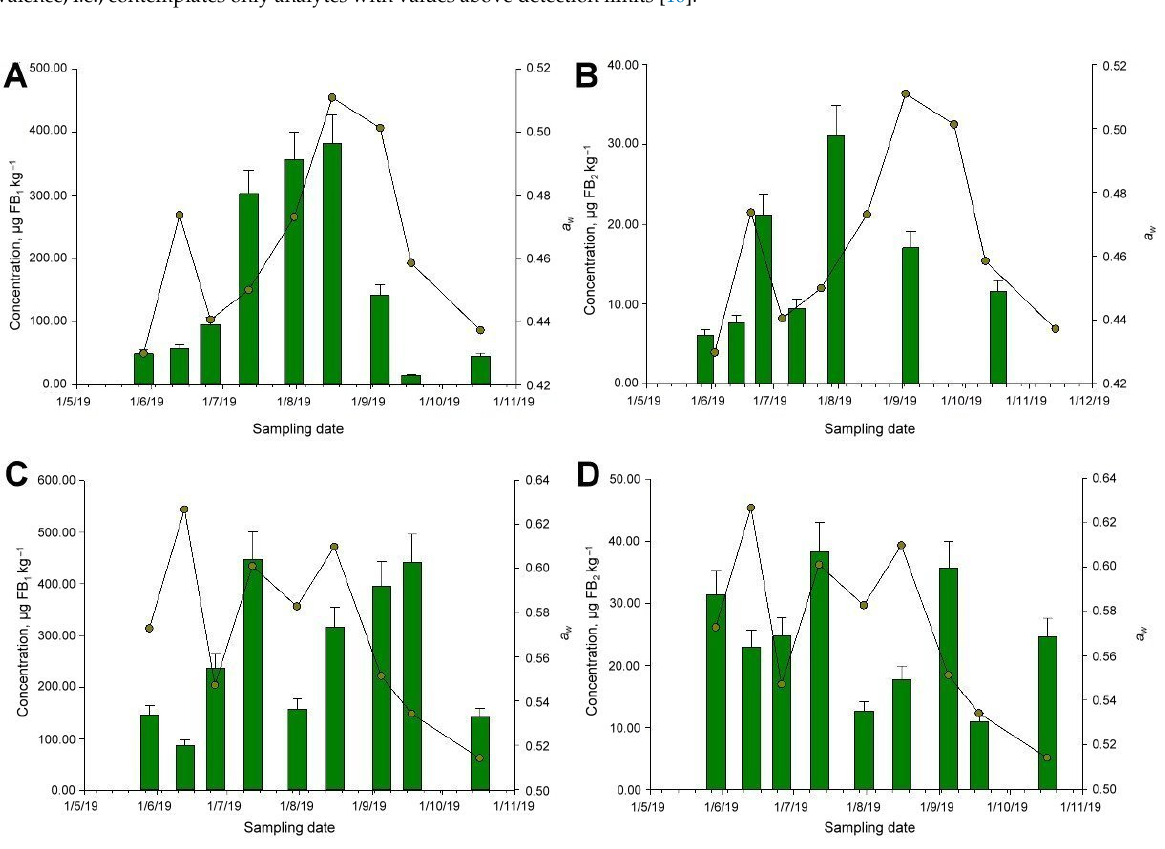
The five Salmonella spp. strain cocktail inoculated at low concentrations in the animal feed for rodents did not show any growth after 48 days of storage at 17 ◦ C. The initial population in the animal feed was 3.4 ± 0.4 log CFU g − 1 and after 48 days the